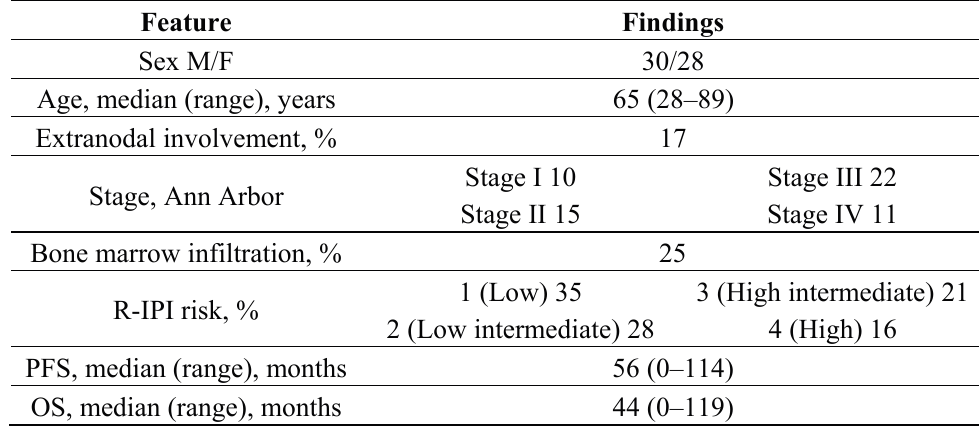
Table 1. Main clinical features of 58